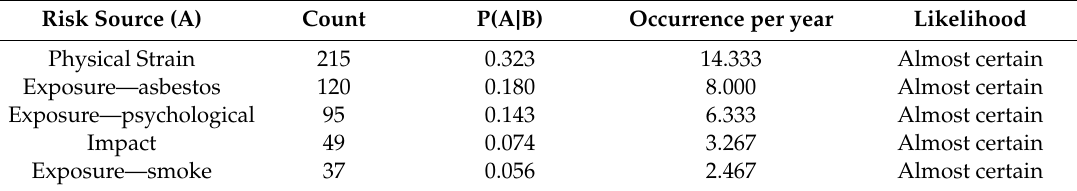
Table 2. Analysis by risk source.